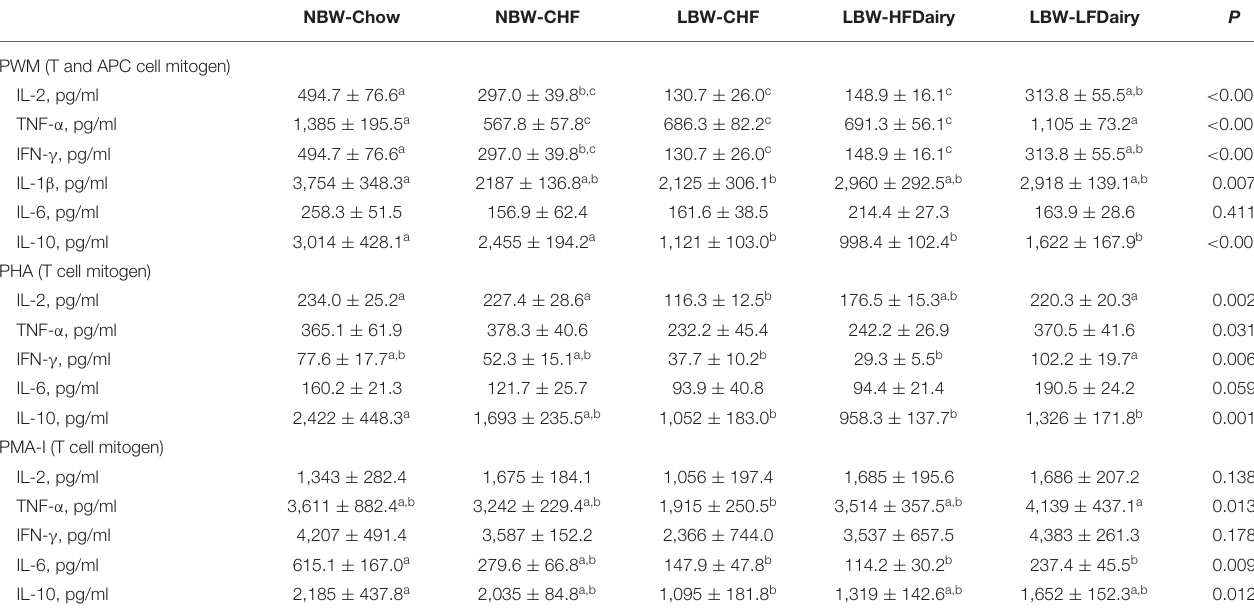
TABLE 2 | Ex vivo cytokine production by mitogen stimulated PBMCs in LBW and NBW swine fed different experimental